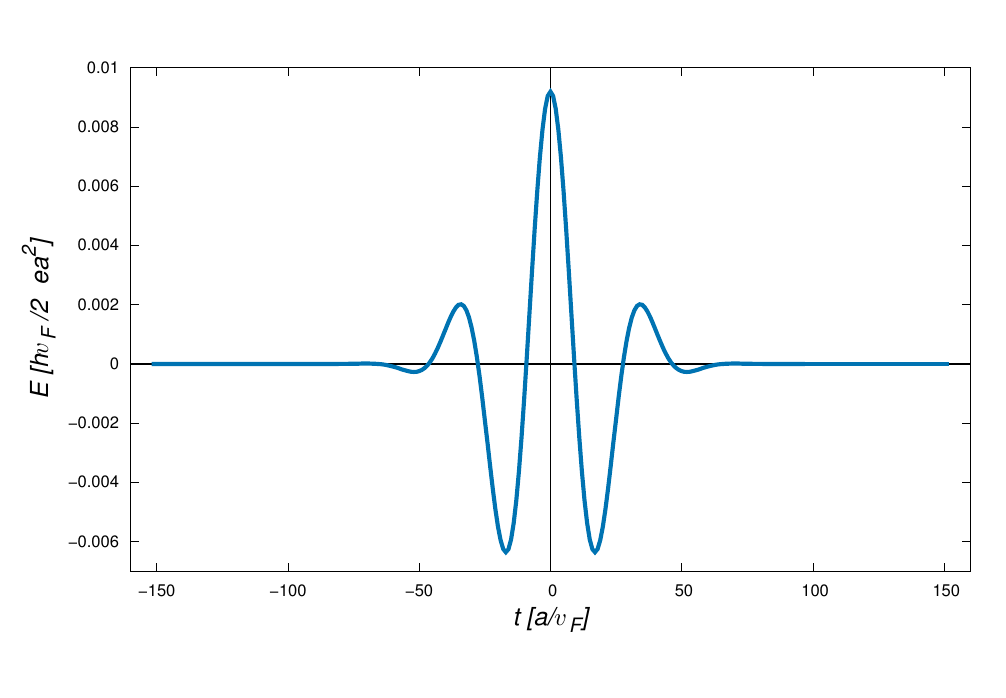
Figure 2. Dependence of field strength on time in the model of the short laser pulse (67). We used the natural graphene units for time [ a / v F ] and field strength [ ¯ hv F / ea 2 ] ( a is the graphene lattice